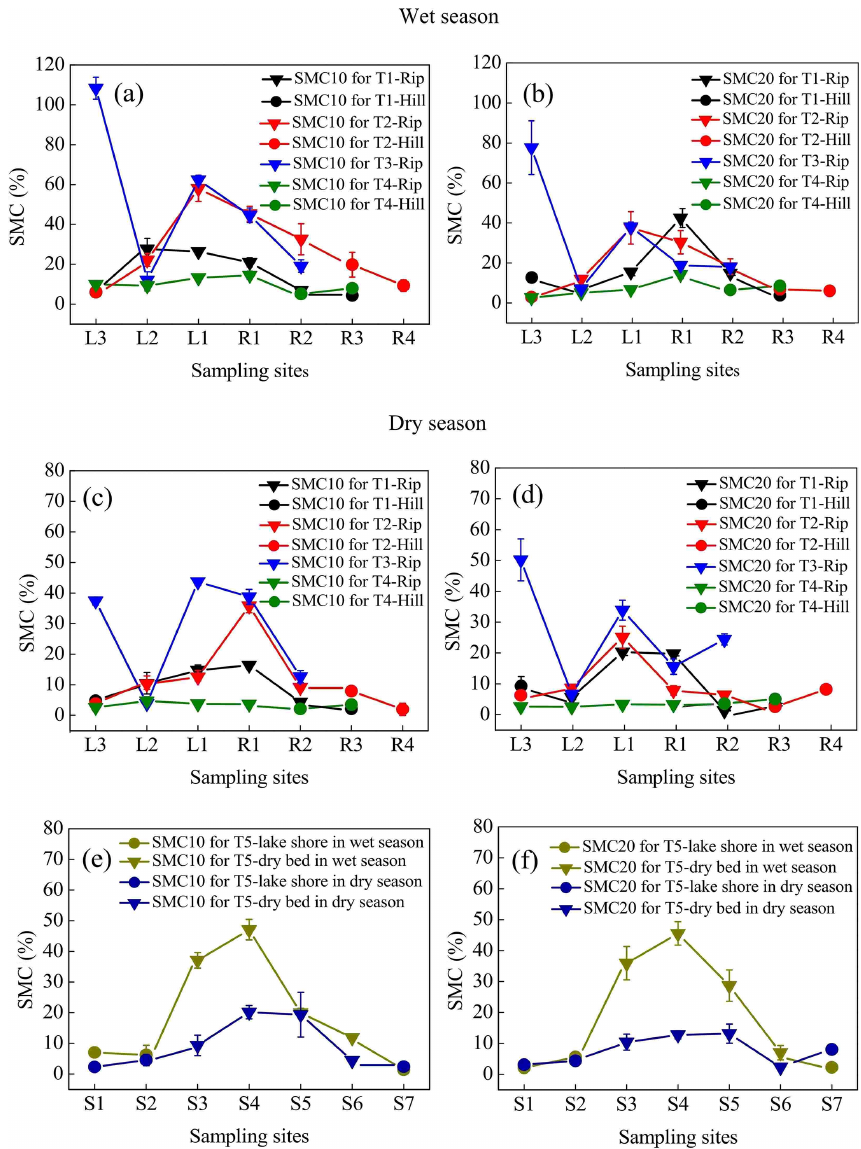
Figure 3. Soil mass moisture contents (SMCs) at soil depths of 0–10cm (SMC10) and 10–20cm (SMC20) for transects T1–T5 in the wet and dry seasons. Error bars represent the SD about the